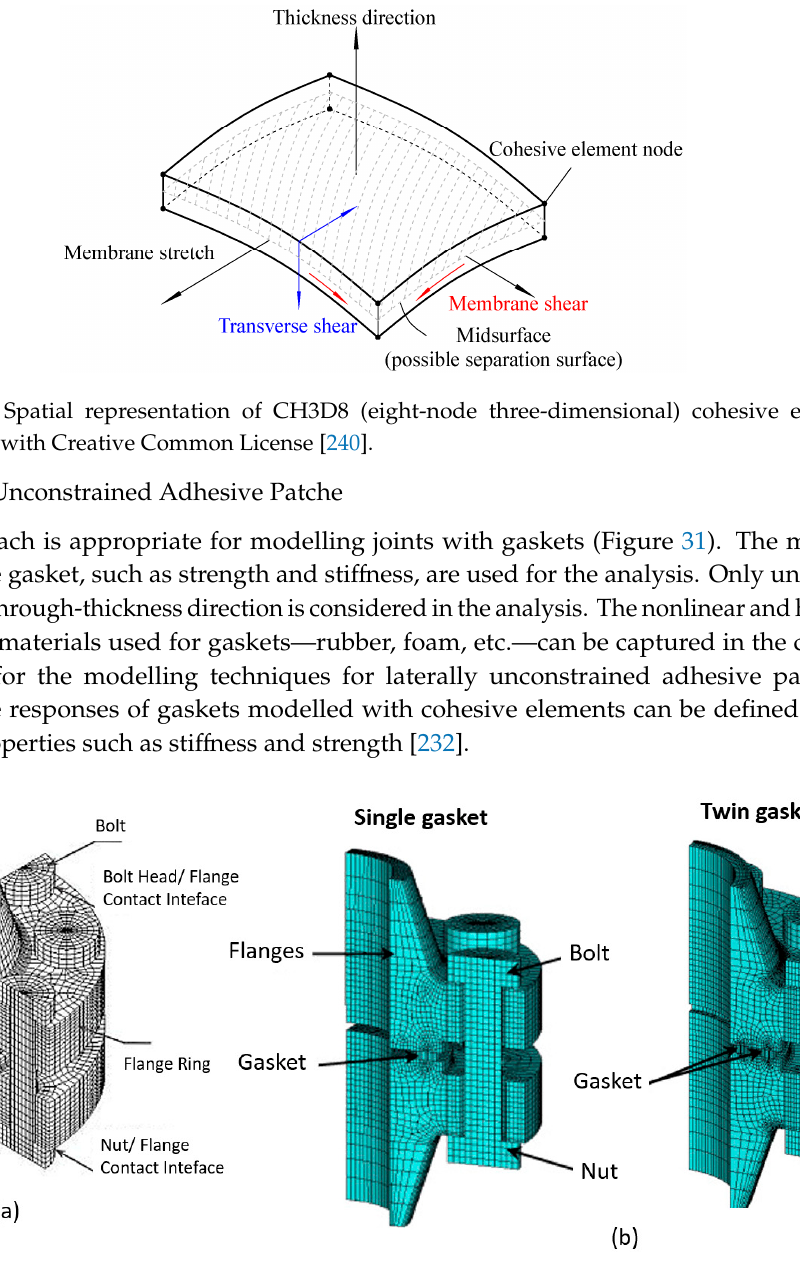
Figure 29. Progressive failure process of the adhesive layer in the lap-shear joint, (a) damage initiation at the overlap edges (SDEG-% = 0), (b) propagation towards the joint centre (SDEG-% ≈ 40), (c) joint failure (SDEG-% = 100). Reproduced with Creative Common License [239].